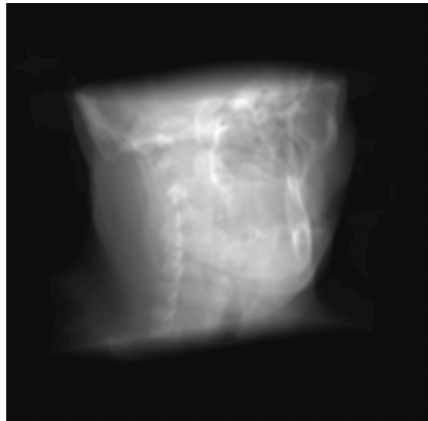
Figure 11: Rendering an oblique projection of the central part of the visible male dataset. The volume is zero-padded and the extracted slice undergoes a high-order resampling by applying a Hamming windowed- 𝑠𝑖𝑛𝑐 reconstruction filter with order 5 to maximally reduce the ghosting